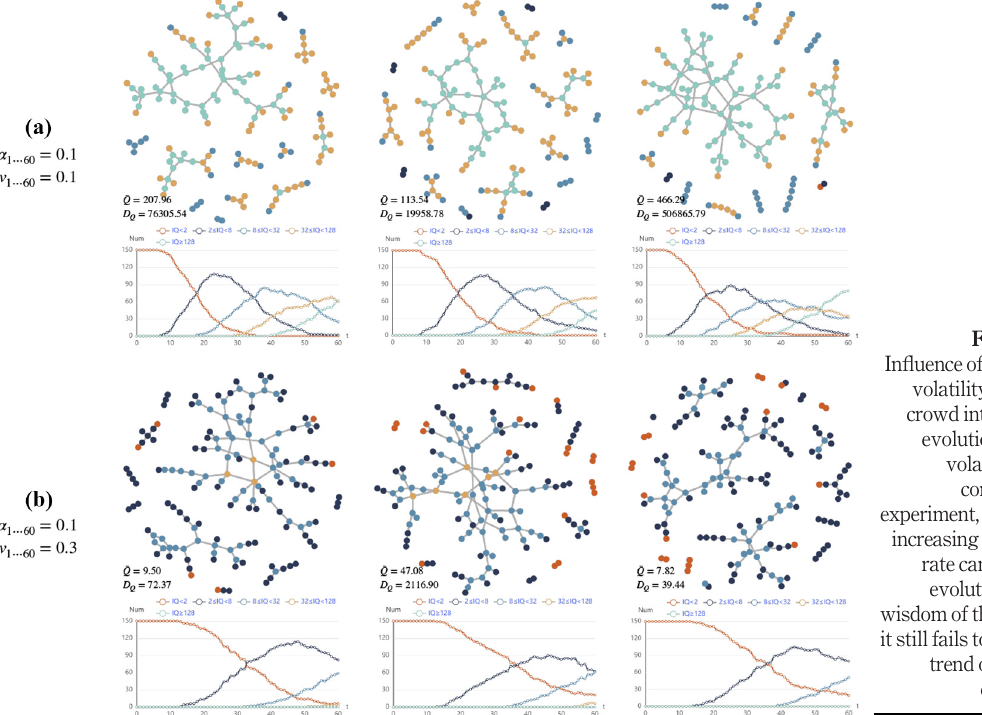
Figure 4. In fl uence of